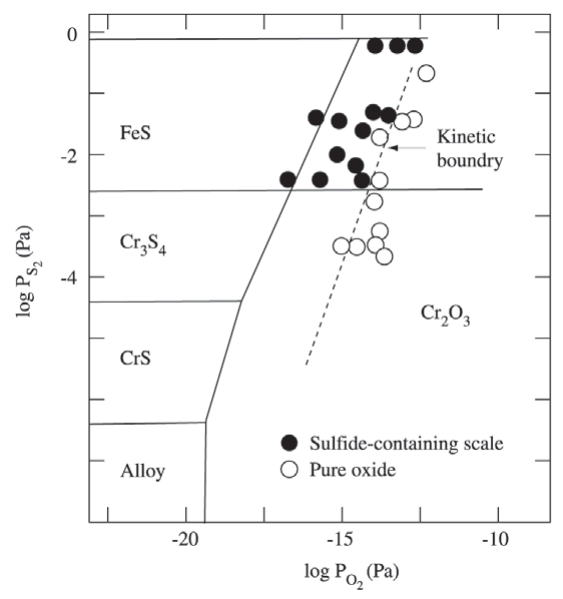
Figure 4. Thermodynamic phase-stability diagram for type 310 stainless steel at 875 °C, showing the experimentally-determined kinetic boundary 2 .